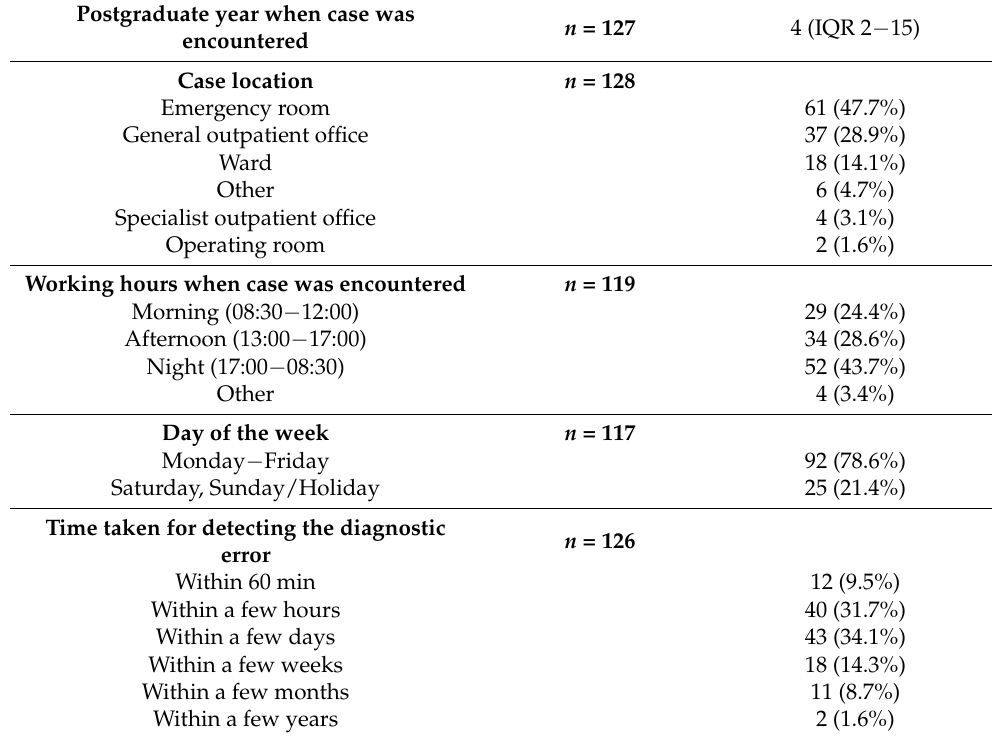
Table 3. Analysis of the most memorable diagnostic error cases reported by